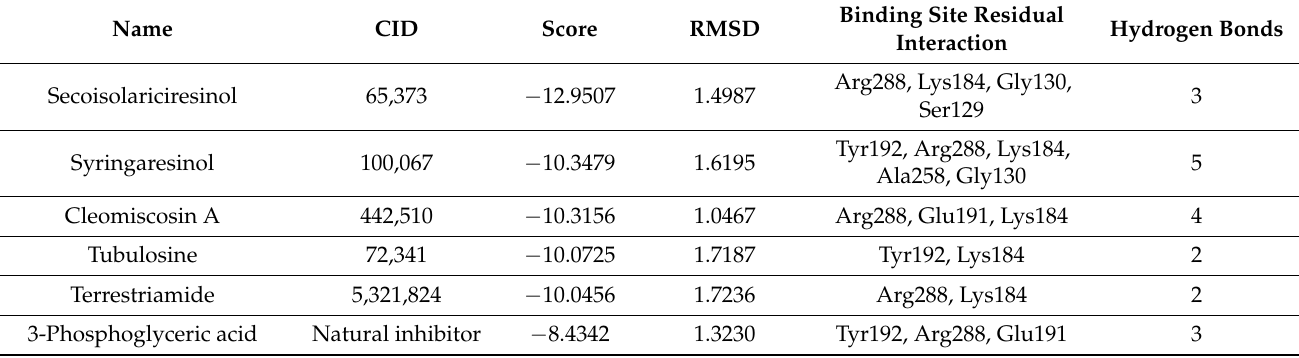
Table 1. Potential hits summary: their binding score, RMSDs, residual interaction and